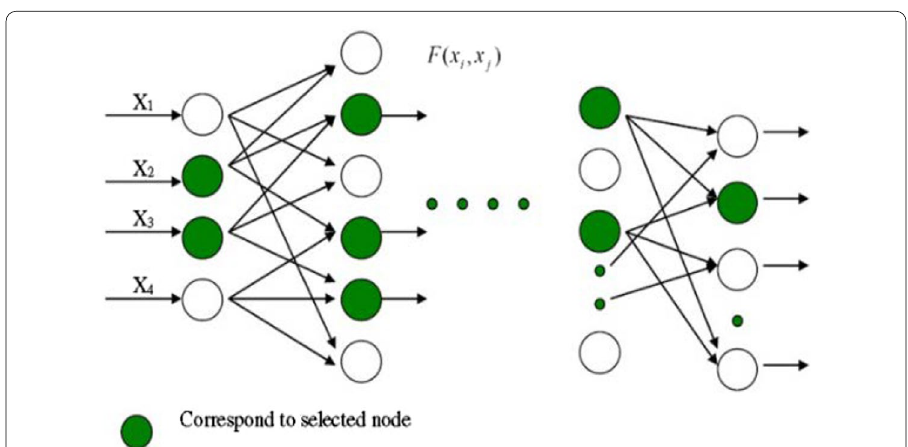
Fig. 3 The structure of LSTM used in the proposed model